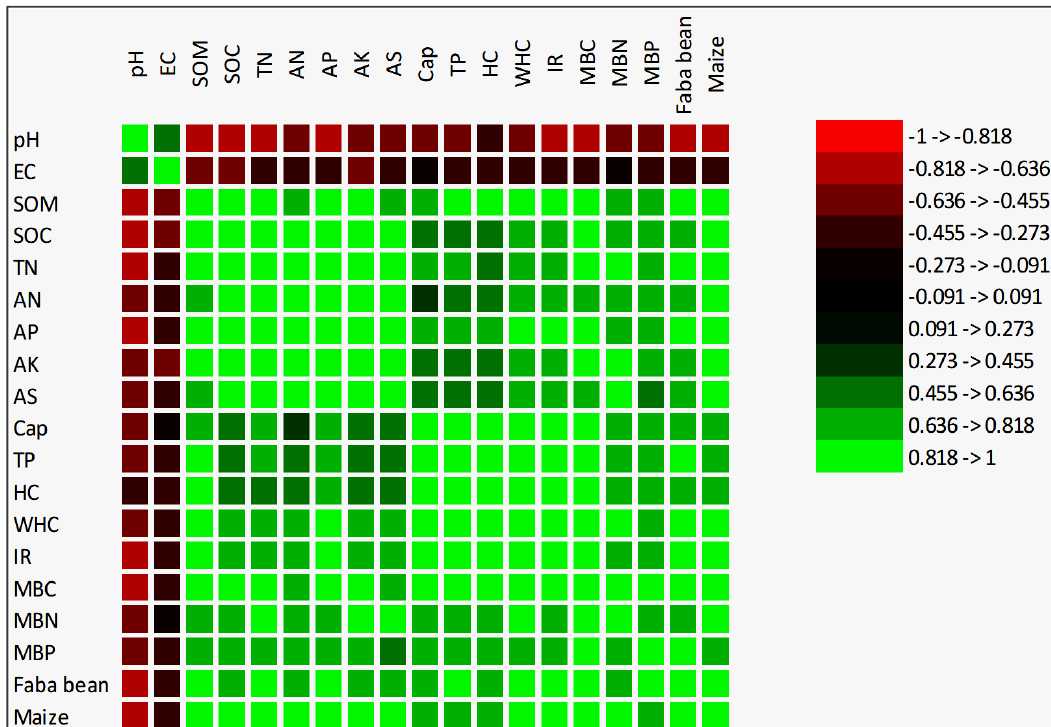
Figure 1. Correlation matrix between soil chemical (pH, EC, soil organic matter (SOM), soil organic carbon (SOC) total nitrogen (TN), available of N (AN), P (AP), K (AK), and S (AS), soil physical (capillary (Cap), total porosity (TP), hydraulic conductivity (HC), water holding capacity (WHC), and infiltration rate (IR)) soil biological (soil microbial biomass carbon (MBC), nitrogen (MBN), and phosphorous (MBP)) properties, and grain yield of faba bean and maize.